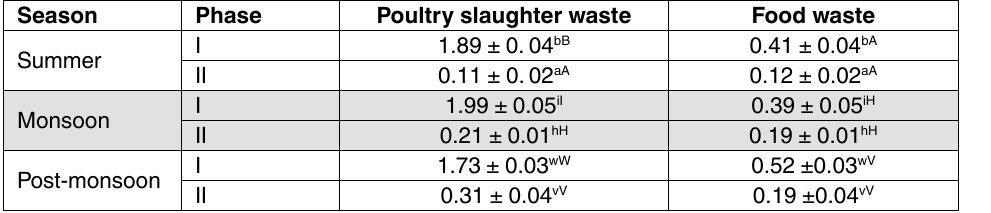
Table 1. Average volume (L) of poultry slaughter waste and food waste leachate